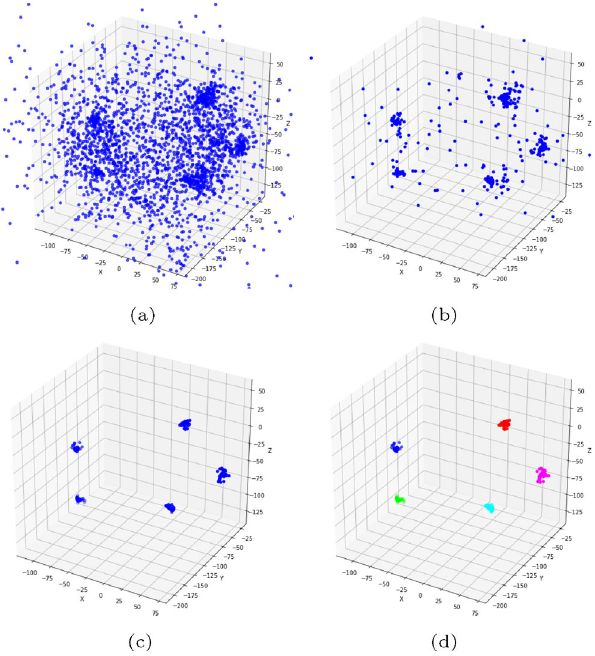
Fig. 4 3D hypothesis space for the left wrist: (a) initial 3D hypothesis space; (b) outlier detection with reprojection error constraint; (c) outlier detection with reprojection error, PAF, and bone length constraints; (d) clustered 3D hypothesis